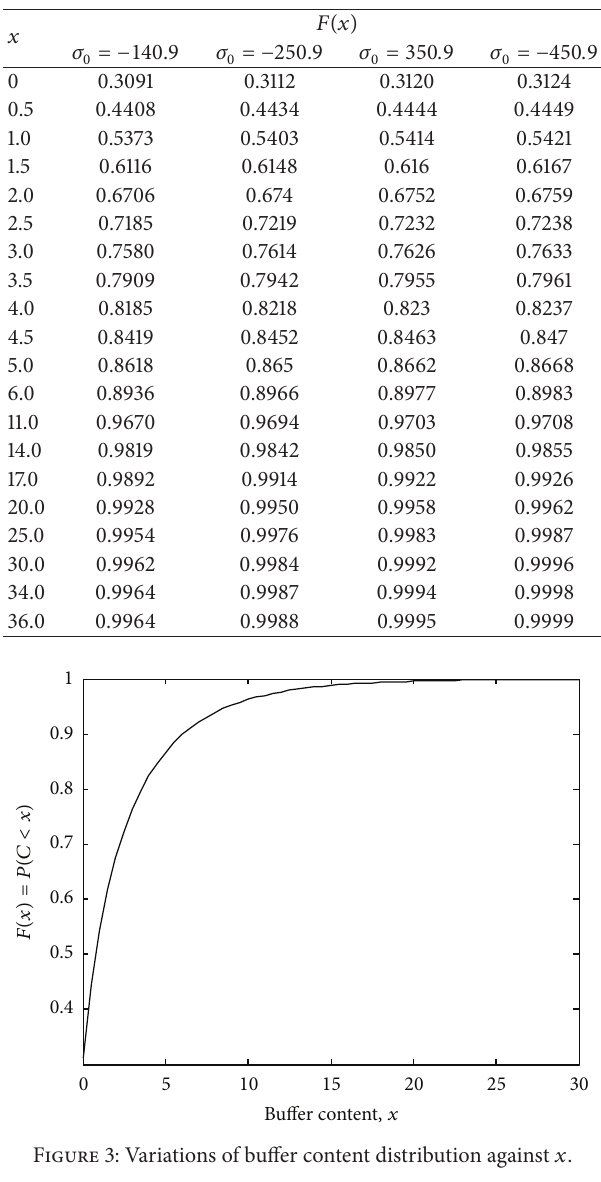
Table 1: Convergence of stationary buffer content distribution for varying values of 𝜎 0 .